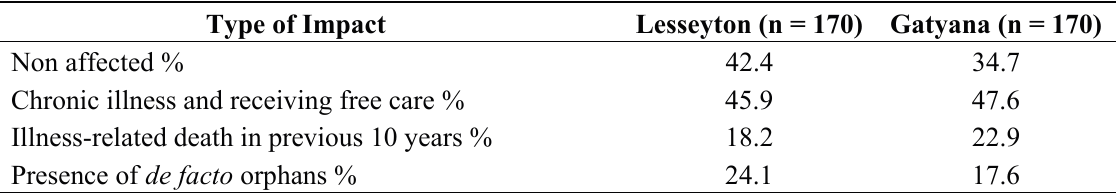
Table 6. HIV/AIDS experiences and presence of proxy indicators in households by site*.